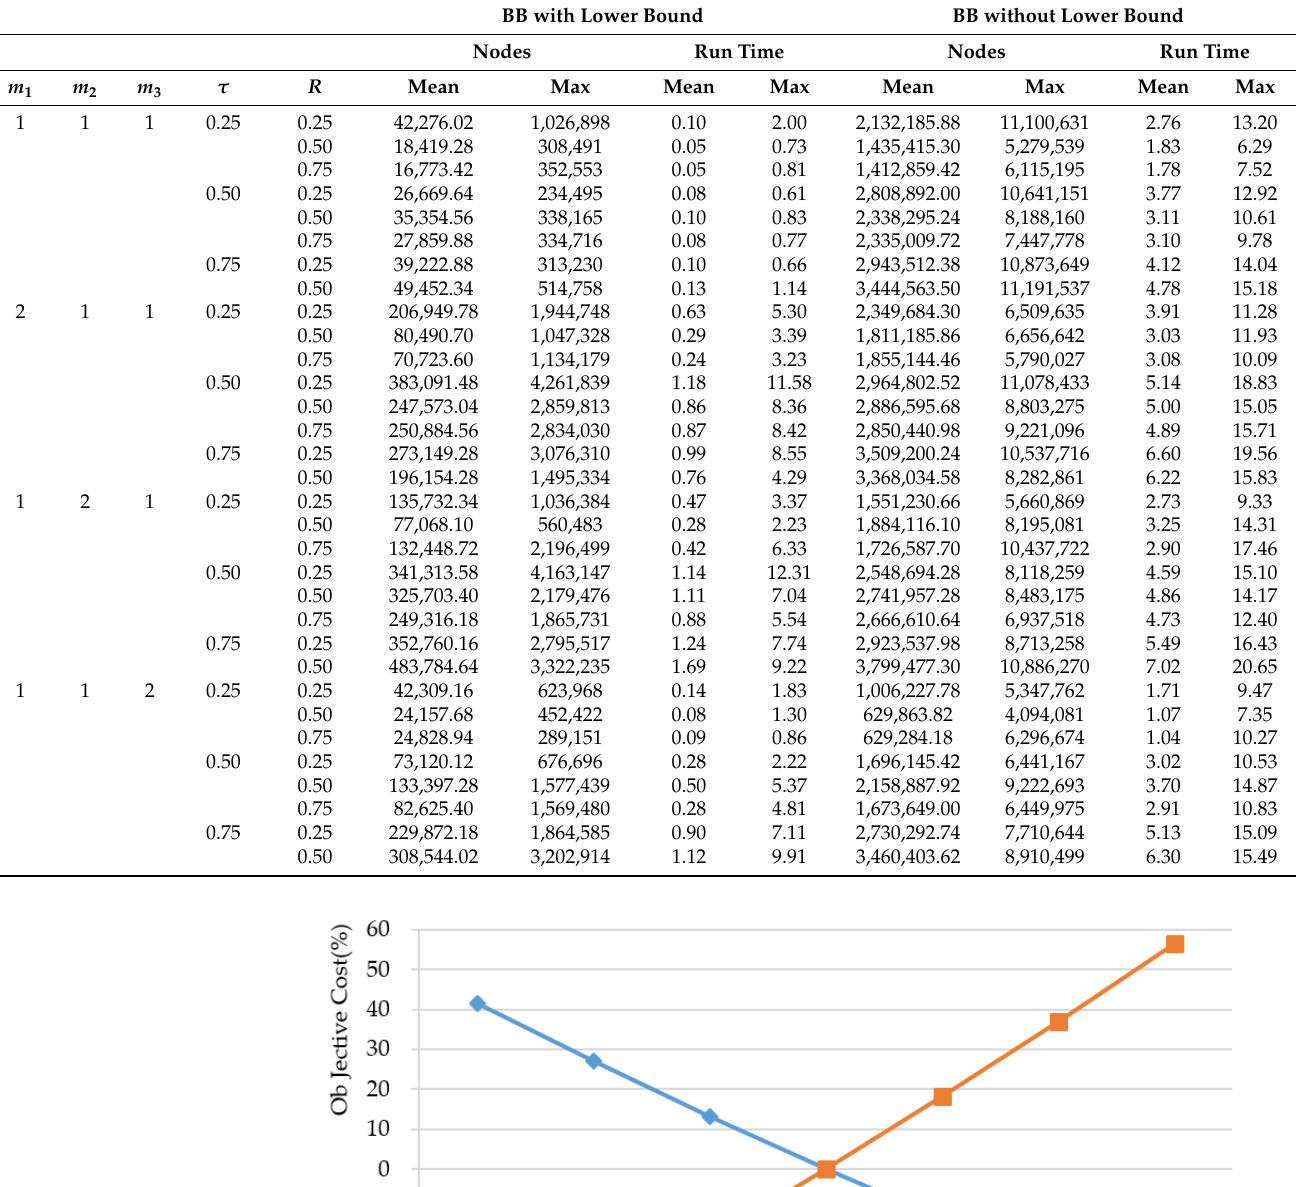
Table 8. The performance of the proposed lower bound for n = 12.